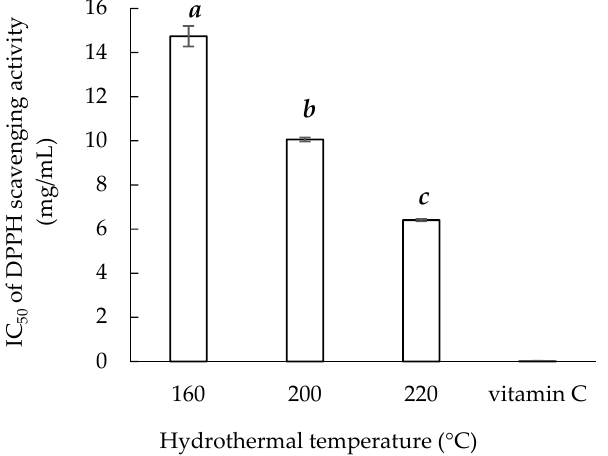
Figure 4. Hydrothermal extraction temperature and DPPH scavenging ability of sericin extracts. Means with the same lowercase letters are not significantly different, per LSD test results.